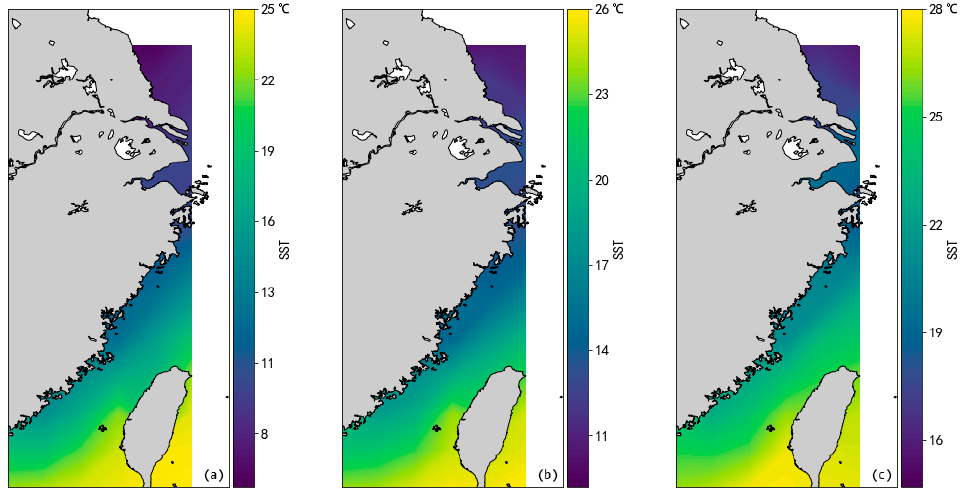
Figure 6. Average temperature in March, April, and May after assimilation. ( a ) Average temperature in March. ( b ) Average temperature in April. ( c ) Average temperature in May. Table 1. Comparison of experimental results of different methods.